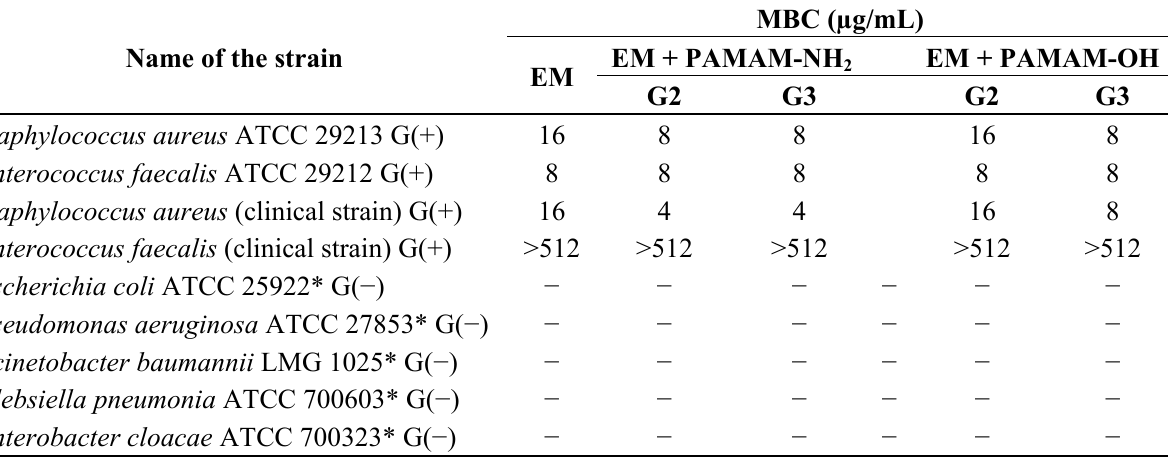
Table 2. Minimum Bactericidal Concentration - MBC (in µg/mL) of erythromycin (EM) in the presence of PAMAM-NH and PAMAM-OH dendrimers generation 2 (G2) and 2 generation 3 (G3).